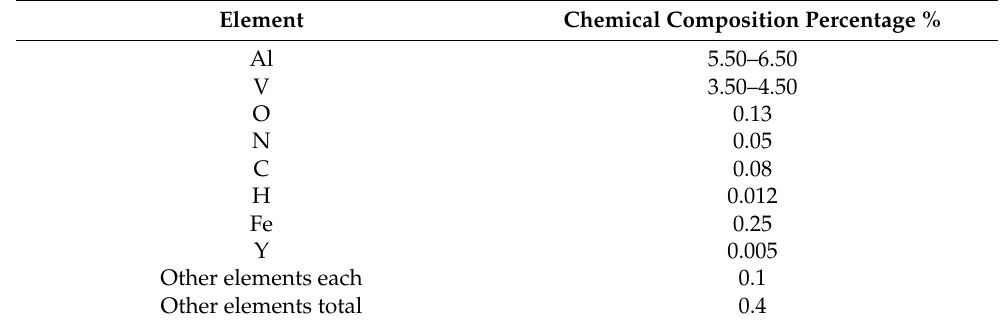
Table 1. Chemical composition of Ti64 powder [37].